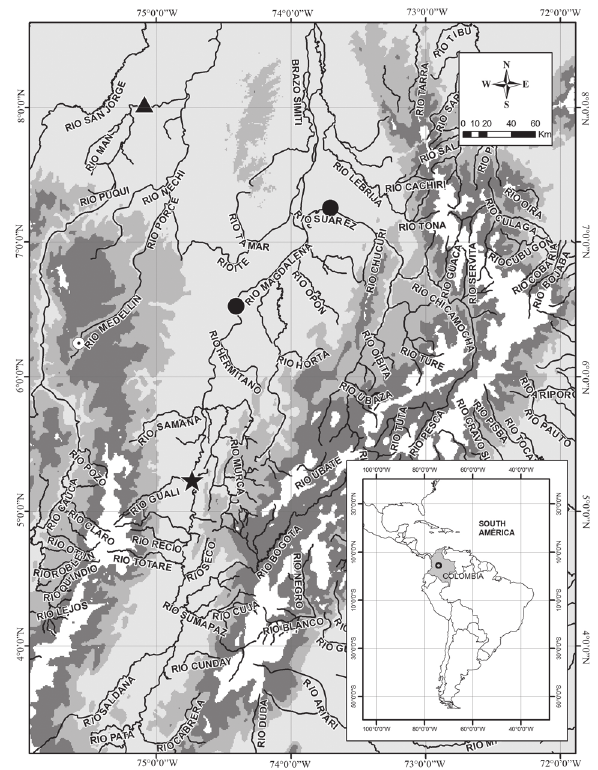
Fig. 3. Distribution of Apteronotus magdalenensis in the río Magdalena, Colombia. Star: type locality; Circles: additional records in the río Magdalena; Triangle: additional record in the lower río